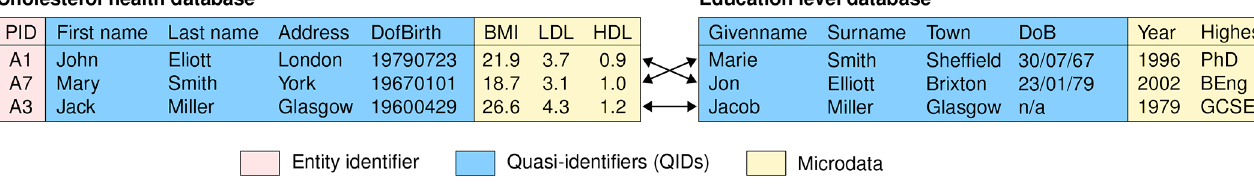
Figure 1: Two small example population databases, where only one contains unique entity identifiers (the PID attribute), but both contain quasi-identifiers (QIDs) and